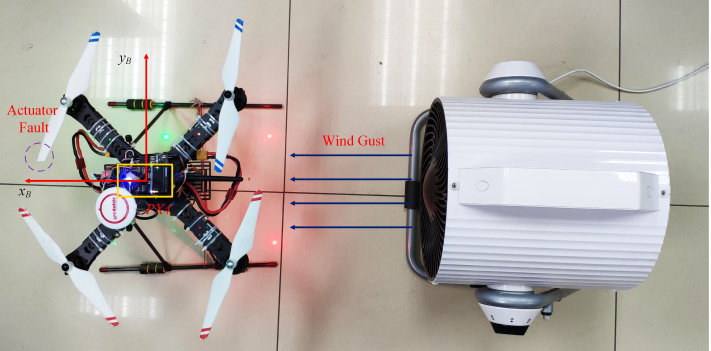
Figure 13. Experimental setup of the quadrotor hovering in the wind field in Case